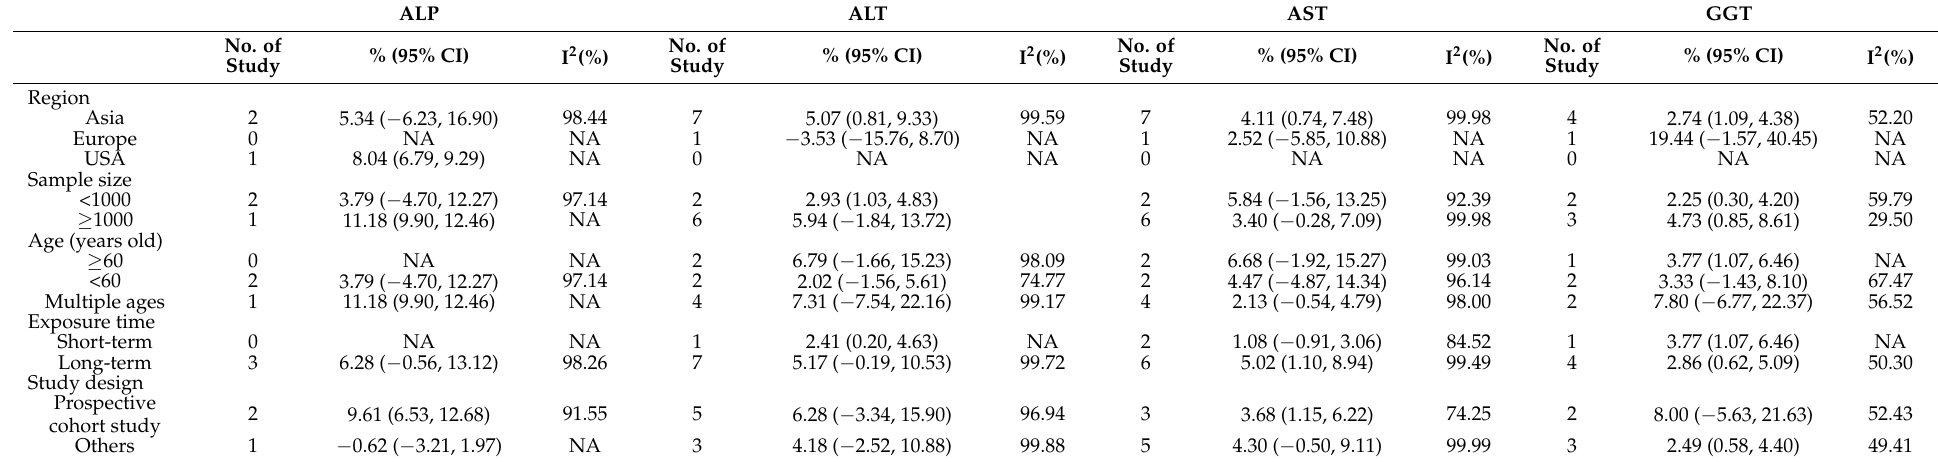
Table 2. Subgroup analyses of the % increase of ALP, ALT, AST, and GGT association with each 10 mg/m 3 increase in PM2.5